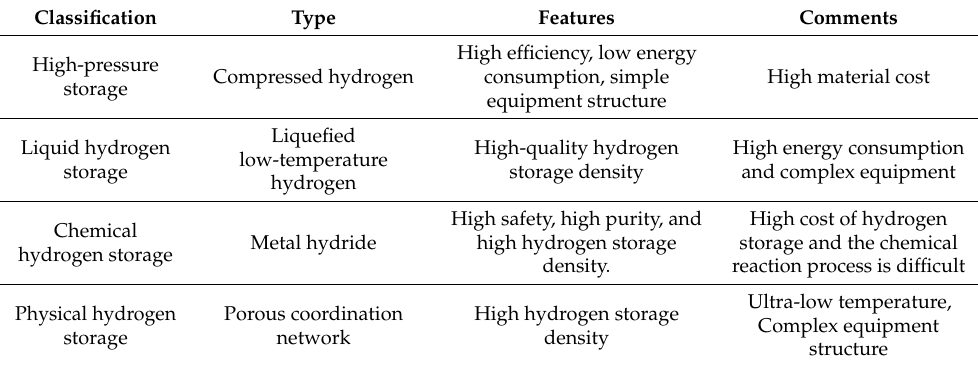
Table 1. Types and comparisons of high-pressure hydrogen